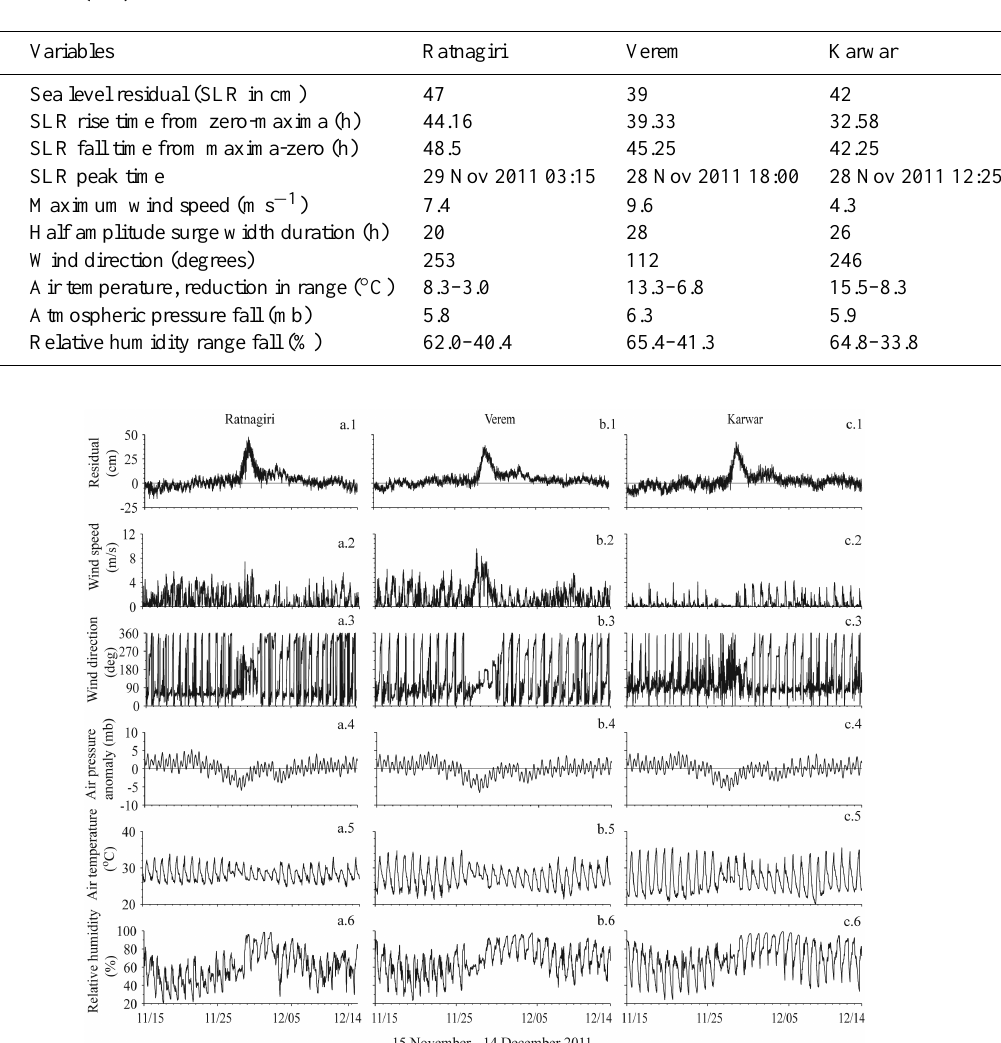
Table 2. Meteorological and sea level observations at Ratnagiri, Verem and Karwar during E1 from 26 November to 1 December 2011. Time is in Indian standard time (IST).